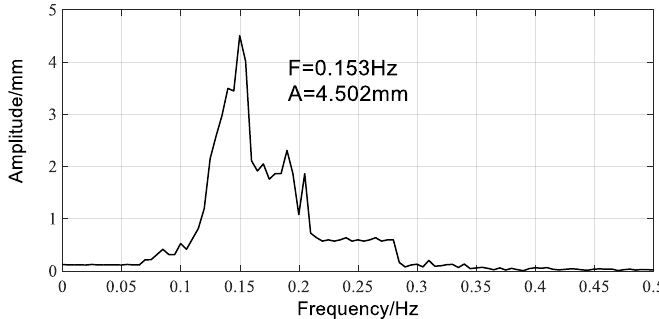
Figure 15. Hilbert time spectrum of the denoised observation sequence in the horizontal direction.